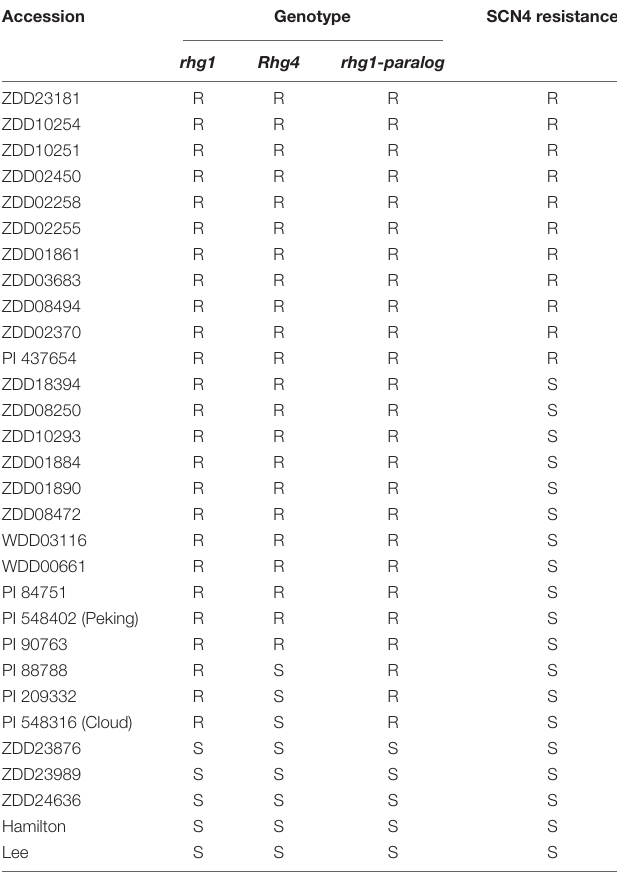
TABLE 2 | Genotypes of three loci for soybean cyst nematode 4 (SCN4) resistance in 30 soybean accessions. Accession